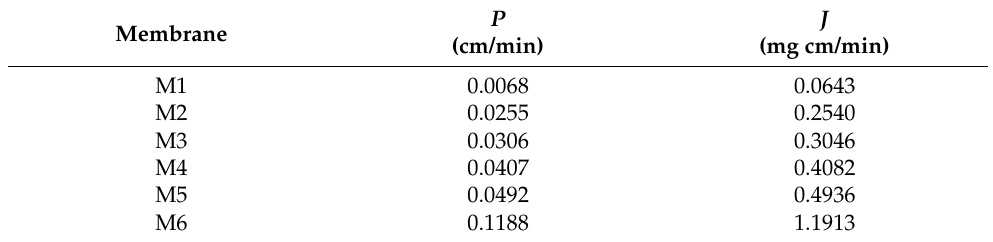
Table 3. Influence of the percentage of the carrier on permeability ( P ) and flux ( J ) of the